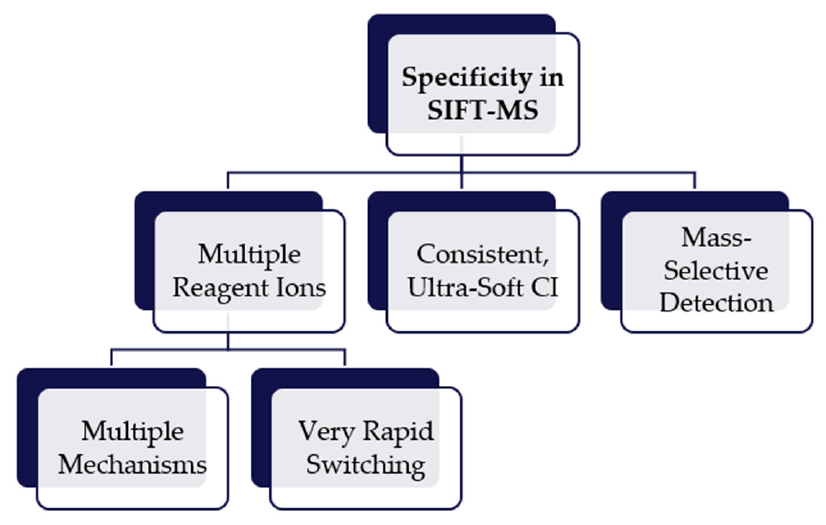
Figure 2. Specificity in SIFT-MS analysis is achieved through a unique combination of attributes.